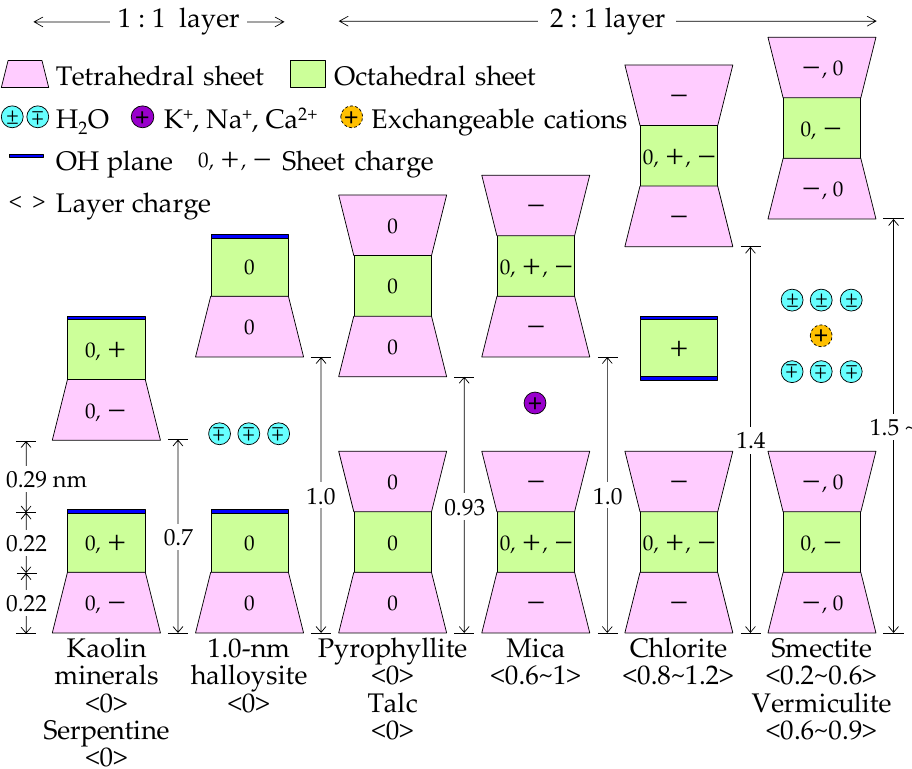
Figure 1. Schematic crystal structure of layer silicates (based on Shirozu [47]). The particle density and specific surface area (Shimadzu Micromeritics Gemini 2375, BET Method, N 2 adsorption, 150–200 C / 60 min) of the clay mineral powder samples are presented in Table 1, and the X-ray di ff raction patterns (Rigaku Ultima IV di ff ractometer, CuK α , 40 kV, 20 mA, 0.15 mm receiving slit, 0.5 divergence slit, 2 scattering slit) of the clay mineral powder samples are depicted in Figure 2. The specific surface area was highest for the smectite (swelling clay minerals) powder sample, followed by the 1.0 nm halloysite (swelling clay minerals) and kaolinite powder samples. The